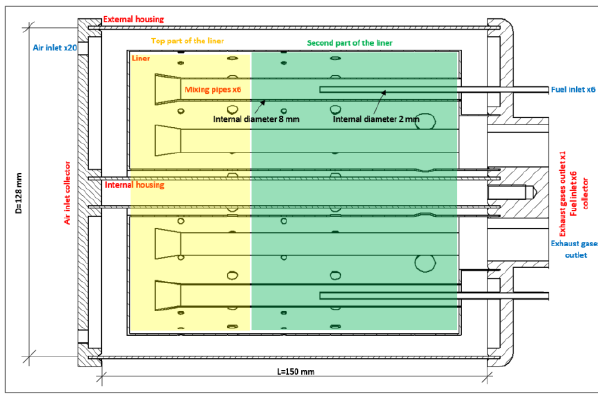
Fig. 2. Cross sectional view of 3D model of reference combustor